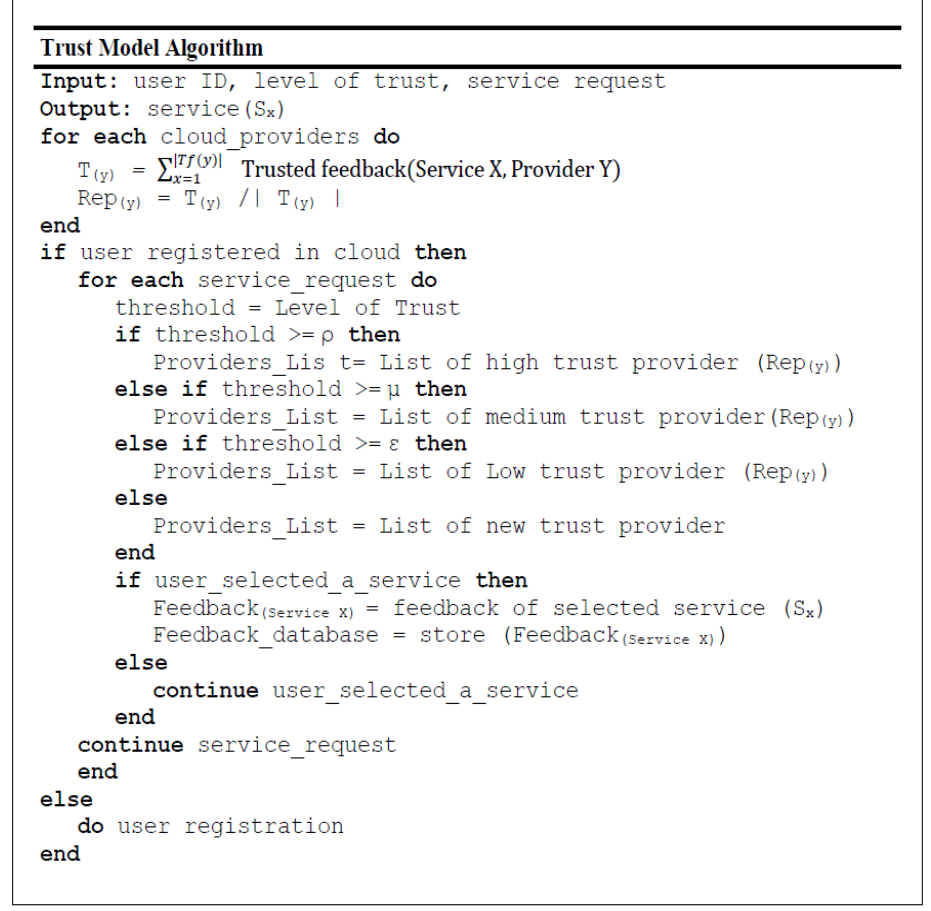
Figure 4. HealthyBroker algorithm pseudo code.